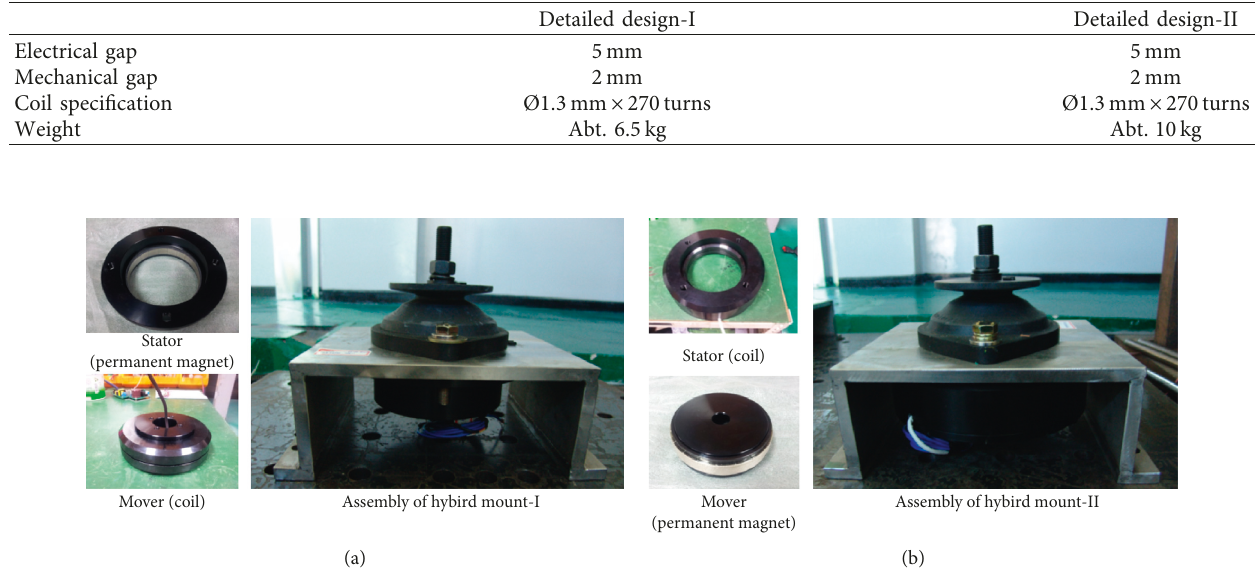
Figure 5: Electromagnetic active mount. (a) Detailed design-I. (b) Detailed